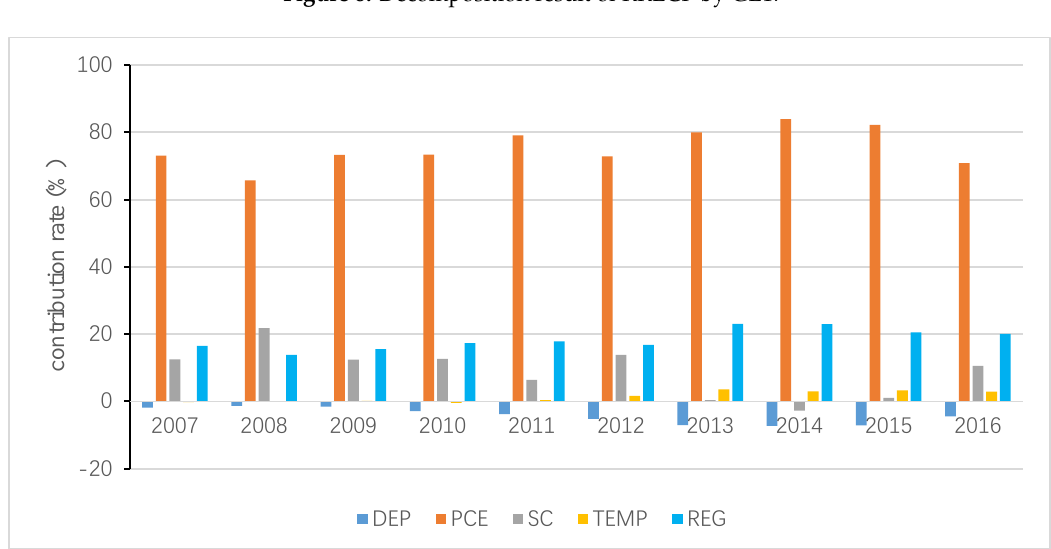
Figure 8. Decomposition result of RRECP by GE1.